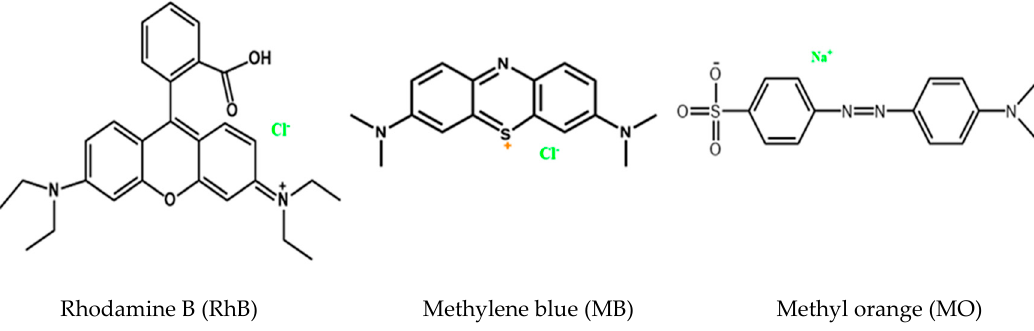
Scheme 5. Chemical structures of the three types of dyes used for photocatalytic